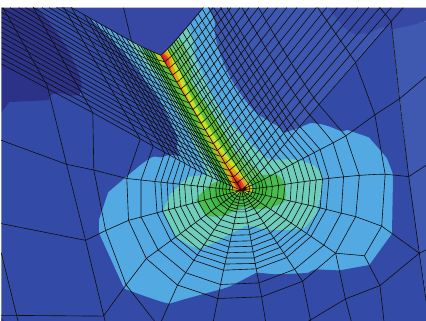
Figure 7: Stress concentration at crack